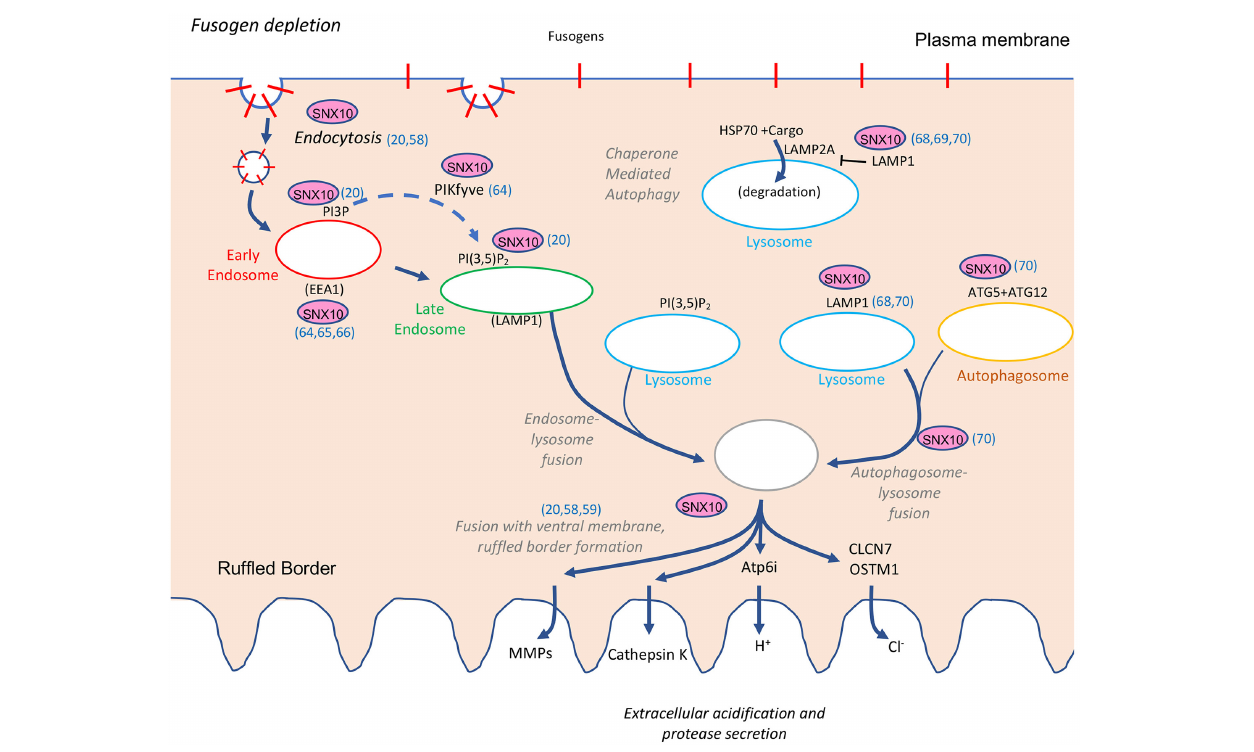
FIGURE 6 | Overview of the known functions of SNX10 along the plasma membrane-to-ruffled border axis. Functions or abilities indicated include support of endocytosis (references Ye et al., 2015 and Barnea-Zohar et al., 2021 noted in the figure), binding to PI3P and PI(3,5)P 2 (Barnea-Zohar et al., 2021), association with PIKfyve, EEA1, and early endosomal markers (Qin et al., 2006; Battaglino et al., 2019; Sultana et al., 2020), inhibition of chaperone mediated autophagy (You et al., 2018; Zhang et al., 2018, 2020), association with LAMP1 and ATG5 and promotion of lysosome-autophagosome fusion (Zhang et al., 2018, 2020), and ruffled border formation (Ye et al., 2015; Stein et al., 2020; Barnea-Zohar et al., 2021). See the section “Cell-Based Studies,” for additional details. PI3P, phosphatidylinositol-3-phosphate; PI(3,5)P 2 , phosphatidylinositol-3,5-diphosphate; Atp6i, the a3 subunit of the V0 domain of the OCL ATP-dependent proton pump; CLCN7, voltage-gated chloride/proton antiporter; OSTM1, beta subunit of the voltage-gated chloride/proton antiporter; CathK, cathepsin K; MMPs, matrix